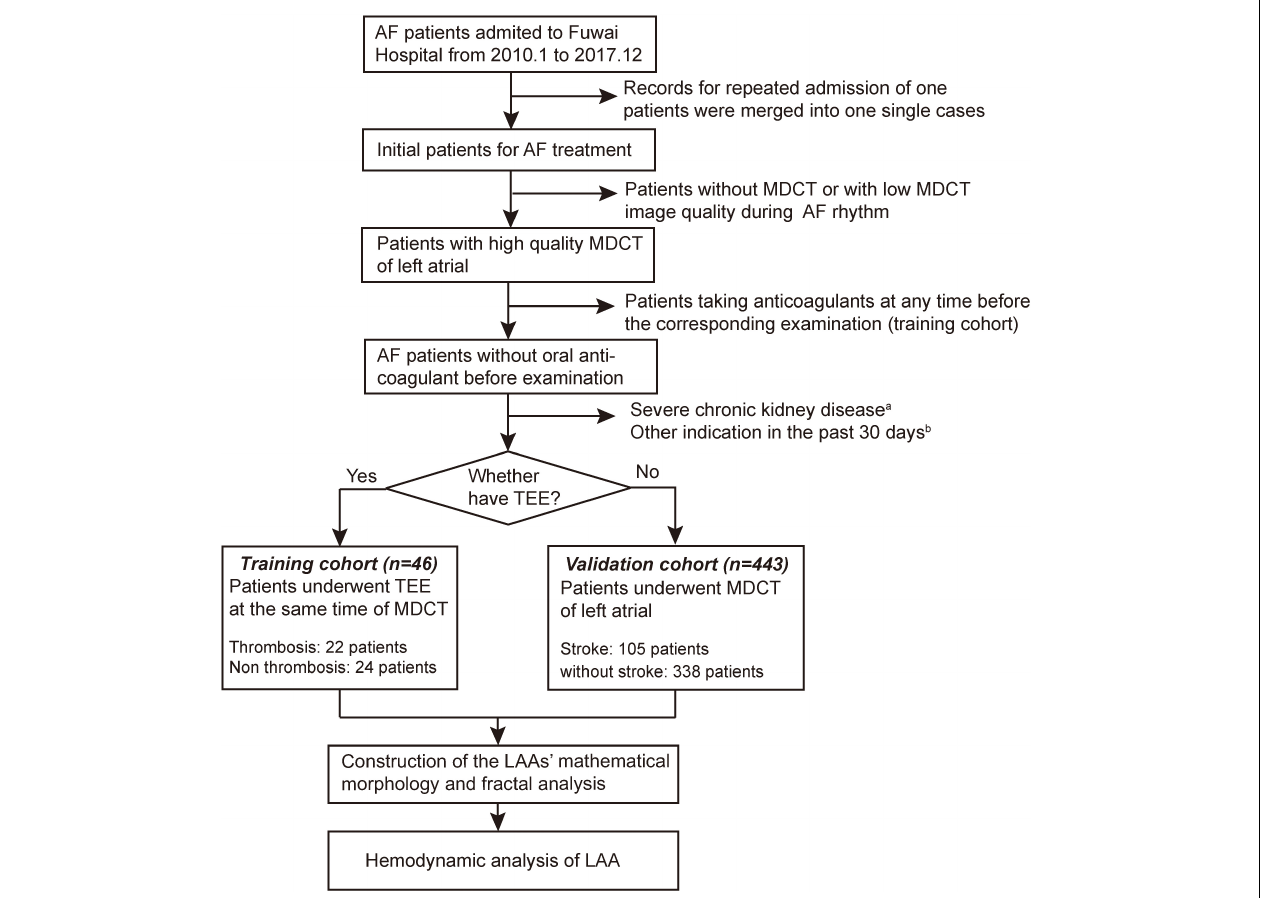
FIGURE 1 | Flowchart of the study. (a) Stage 4 or 5 or end-stage chronic kidney disease. (b) Deep vein thrombosis/pulmonary embolism, hip/knee replacement, femur/tibia/patella fracture, thrombectomy, or chronic hypercoagulable